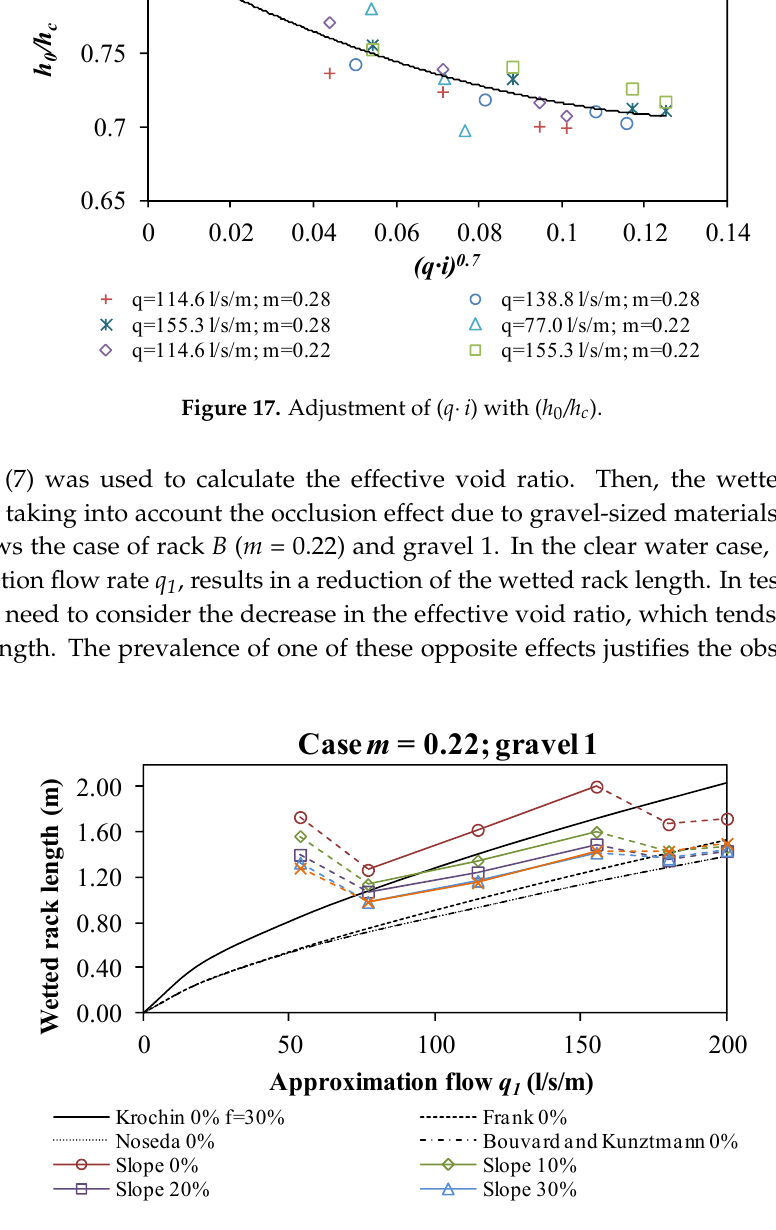
Figure 18. Wetted rack lengths for racks B and gravel 1 defined with experimental test and adjusted (dashed line) with Equation (7).